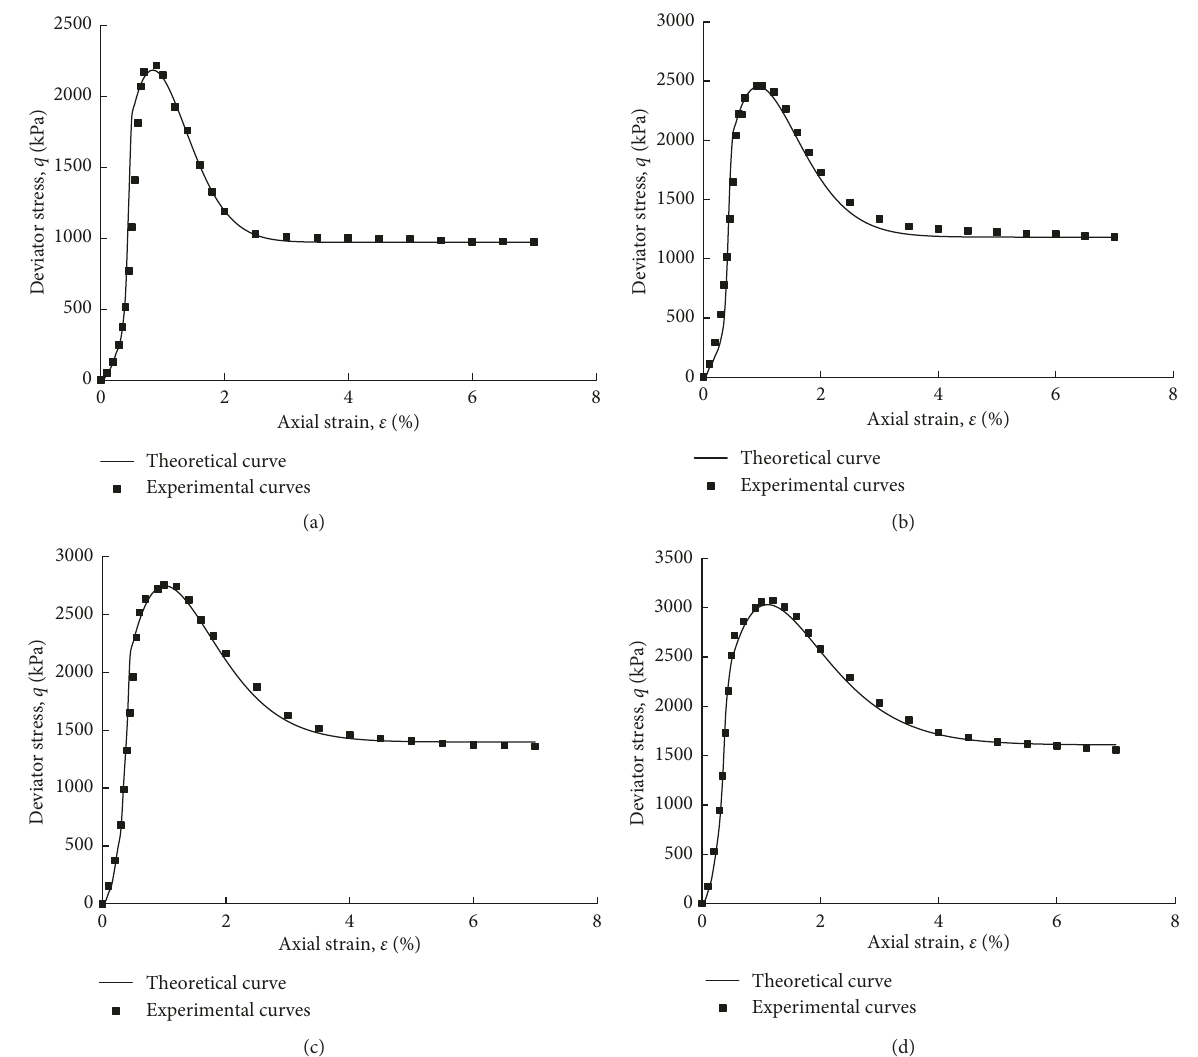
Figure 8: Experimental and theoretical curves under different confining pressures. (a) σ (cid:31)